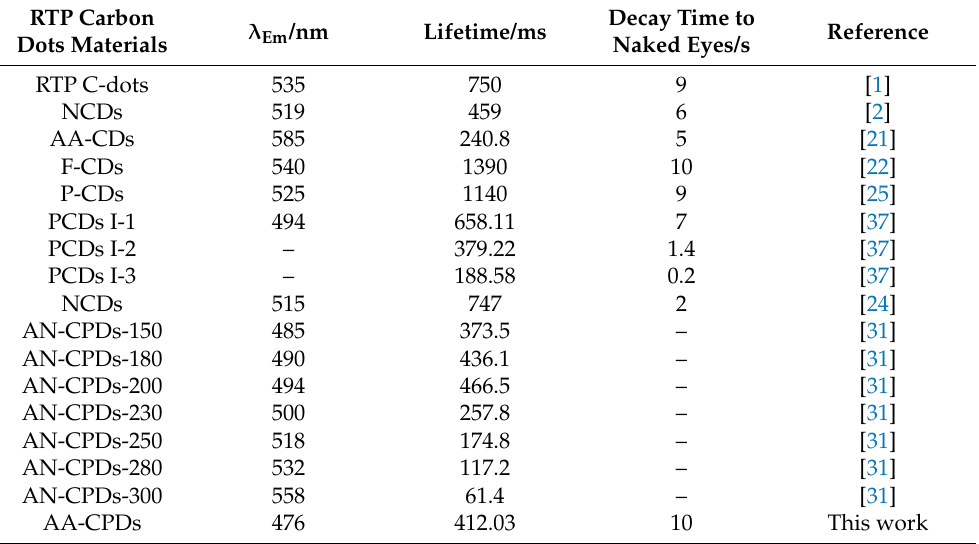
Table 1. A comparison between the decay time to naked eyes and the lifetime of afterglow for the AA-CPDs with those of RTP carbon dots. RTP